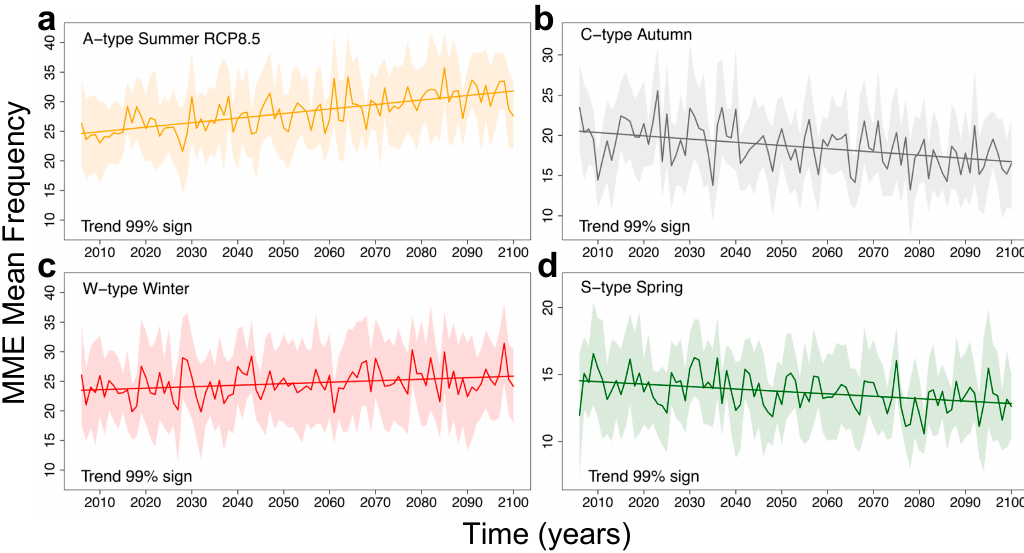
Figure 5. Projected annual frequencies for selected LWTs and seasons under RCP8.5. Frequencies are shown as MMEM for ( a ) A-type (summer JJA), ( b ) C-type (autumn SON), ( c ) W-type (winter DJF) and ( d ) S-type (spring MAM) LWTs under RCP8.5 (2006–2100). Trends are statistically significant at the 1% level ( p -value < 0.01, modified Mann-Kendall test). Shaded areas represent the 95% confidence intervals of the MMEM. The trend lines refer to the Sen’s slopes calculated with the modified Mann-Kendall test.